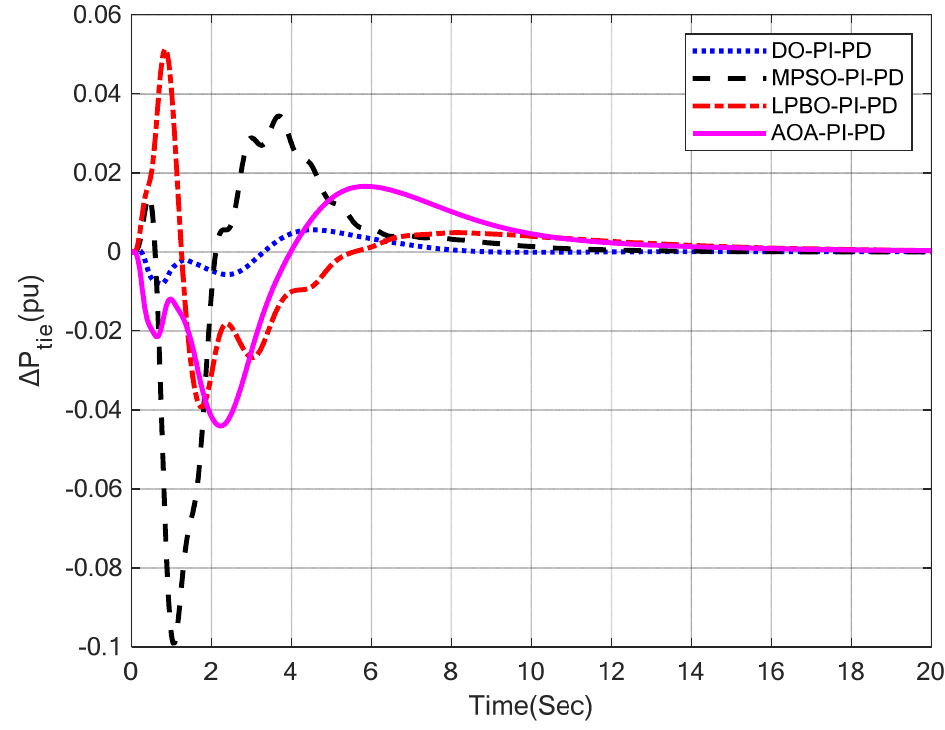
Figure 13. Tie-line power deviation responses in a two-area multi-source realistic IPS with nonlinearities. Table 11. Numerical results of tie-line power deviation in a two-area multi-source realistic IPS with nonlinearities.